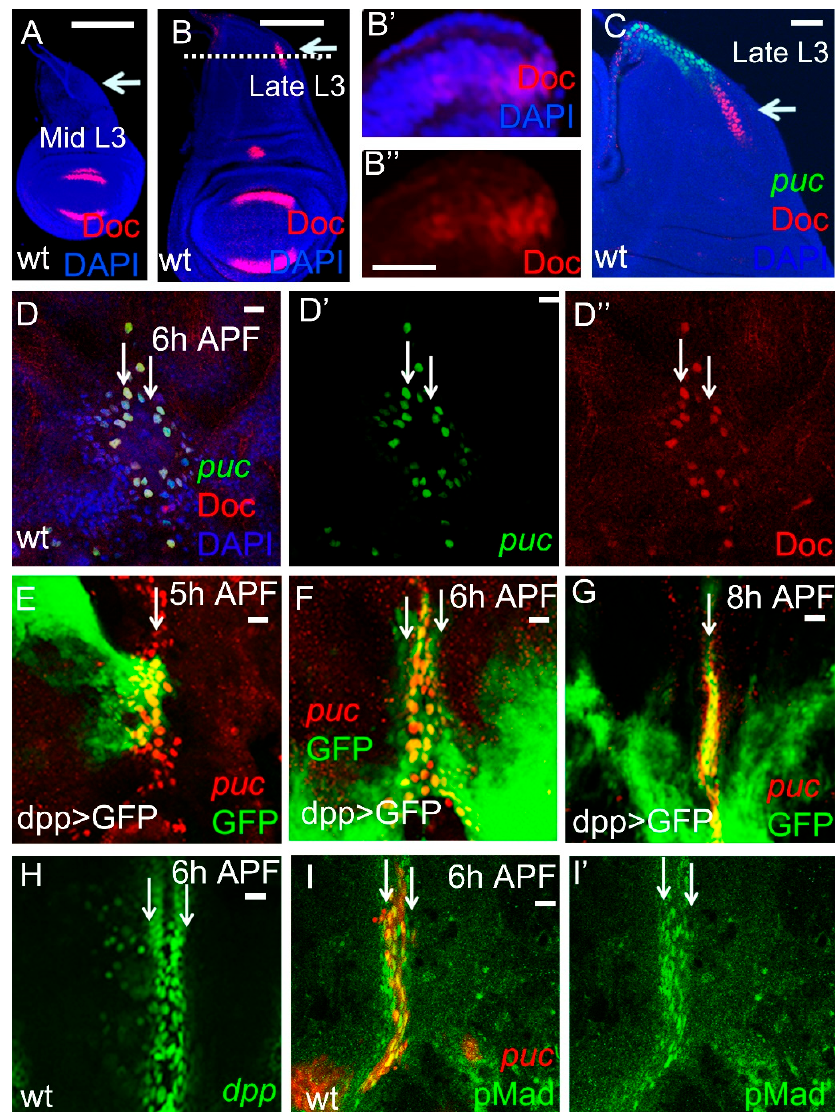
Figure 1. Dpp and Doc are expressed in the leading edge cells during Drosophila thorax closure. In this and subsequent figures, L3 wing discs and early pupal nota are shown. Other developmental stages are indicated. Wing discs are oriented with dorsal up and anterior left. Pupal nota are orientated with anterior up and the future fusion line in the middle. ( A ) At mid L3, Doc is not yet expressed in the posterior notum region. ( B ) At late L3, Doc expression arises in the future posterior notum. A cross view of the dotted line in ( B ) is shown in ( B’ , B” ). Doc was only expressed in the columnar epithelium, but not in the peripodial epithelium cells. ( C ) At late L3, Doc and JNK are expressed in a complementary manner in the notum region, while at 6h APF ( D ), puc-lacZ ( D’ ) and Doc ( D” ) are co-expressed in the leading edge cells. ( E – G ) dpp expression is revealed by UAS-GFP expression in the dpp-Gal4 domain. Note that GFP is expressed in the leading edge cells (white arrows in E – G ) throughout thorax closure from 5 to 8 h APF. puc-lacZ (red) is used as a marker of the leading edge cells. ( E ) At 5 h APF, the two separate heminota are moving toward the midline. Only a few puc-lacZ positive cells express GFP . ( F ) At 6 h APF, the two nota have established contact and start to fuse. ( G ) At 8 h APF, the two heminota have fused and form a continuous structure. GFP is still visible in the fusion midline. ( H ) dpp-lacZ expression (green) is observed in cells along the fusion midline. ( I ) pMad staining (green) ( I’ ) indicates that Dpp signaling activity is high in the leading edge cells. The white arrows indicate the Doc expression region from 3rd instar larvae to 6 h APF. Scale bars, 2 μ m.